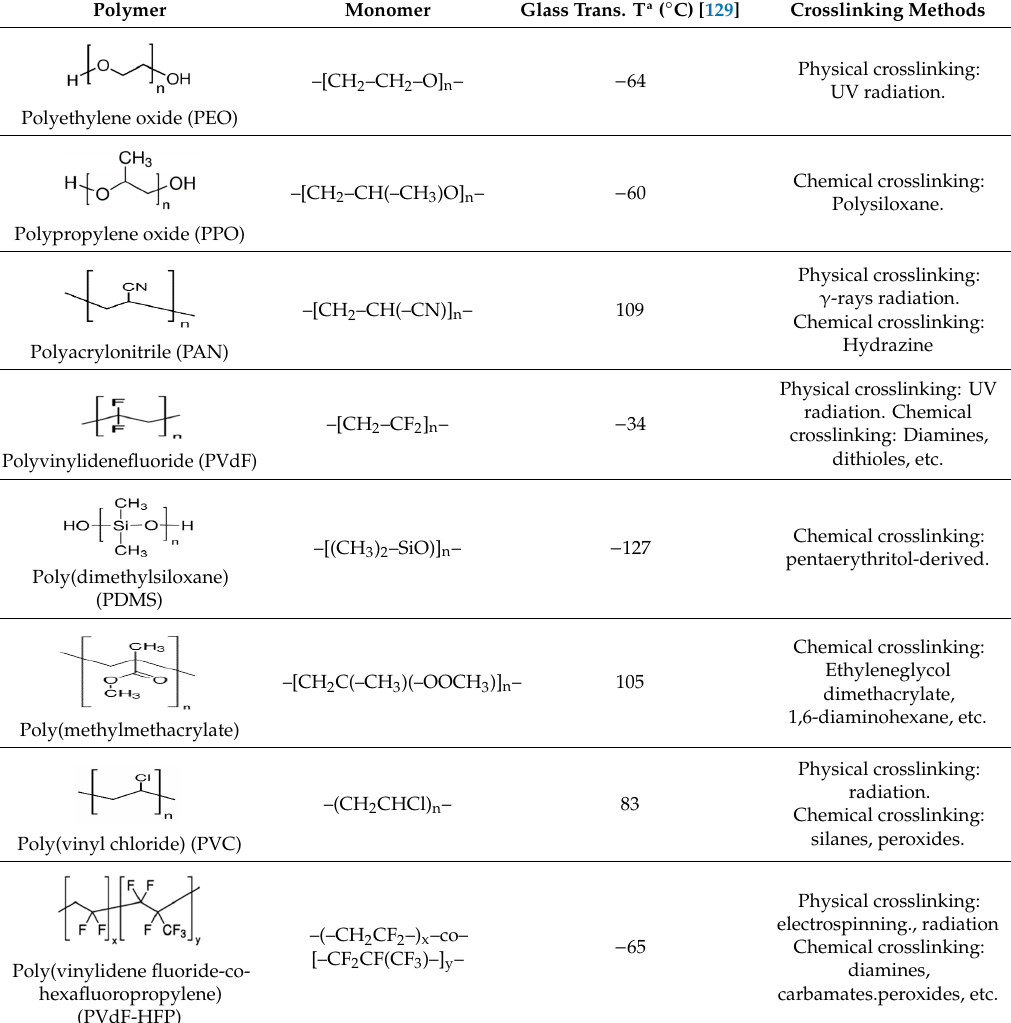
Table 2. Common popular polymers used for making GPEs.